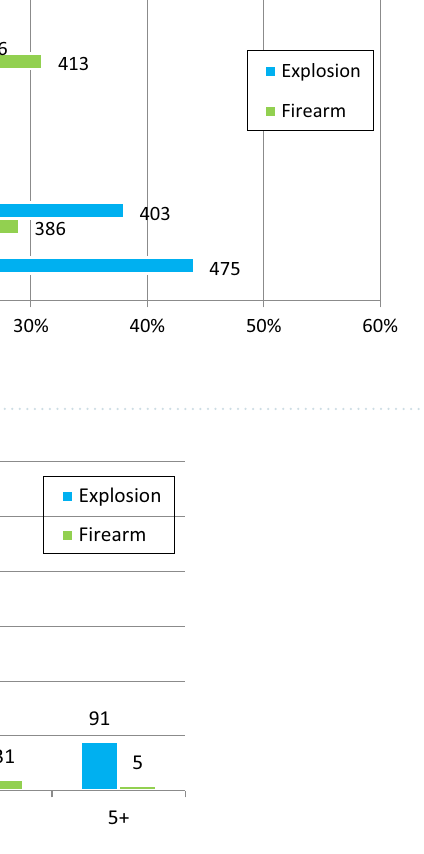
Figure 3. Number of body regions injured by injury mechanism (based on nine body